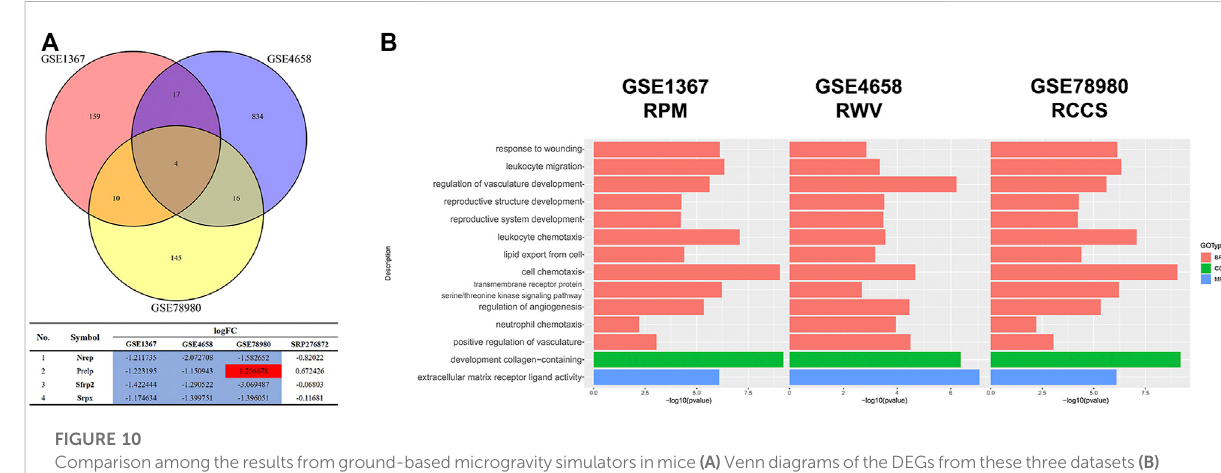
FIGURE 10 Comparisonamongtheresultsfromground-basedmicrogravitysimulatorsinmice (A) VenndiagramsoftheDEGsfromthesethreedatasets (B) Overlapping GO analysis results from these three